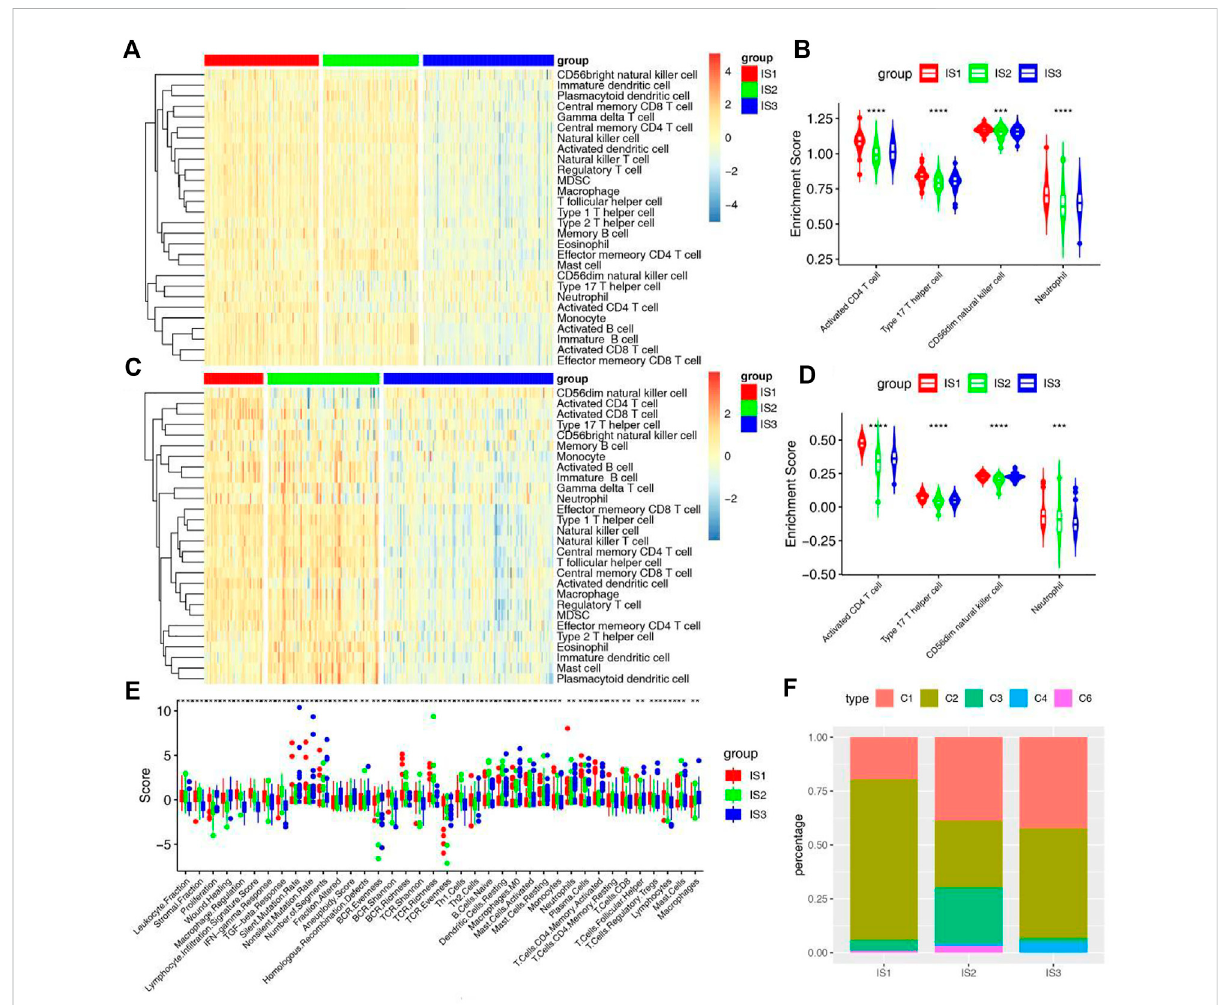
FIGURE 5 Cellular and molecular characteristics of immune subtypes. (A) Differential enrichment scores of 28 immune cell signatures among STAD immune subtypes in training cohorts. (B) Differential enrichment scores of 4 prognostically relevant immune cell signatures in training cohorts. (C) Differentialenrichmentscoresof28immunecellsignaturesamongSTADimmunesubtypesinGSE66229cohorts. (D) Differentialenrichmentscores of 4 prognostically relevant immune cell signatures in GSE66229 cohorts. (E) Differential enrichment scores of 56 immune signatures among STAD immune subtypes and 38 immune signatures with FDR < 0.01. (F) Overlap of STAD immune subtypes with 6 pancancer immune